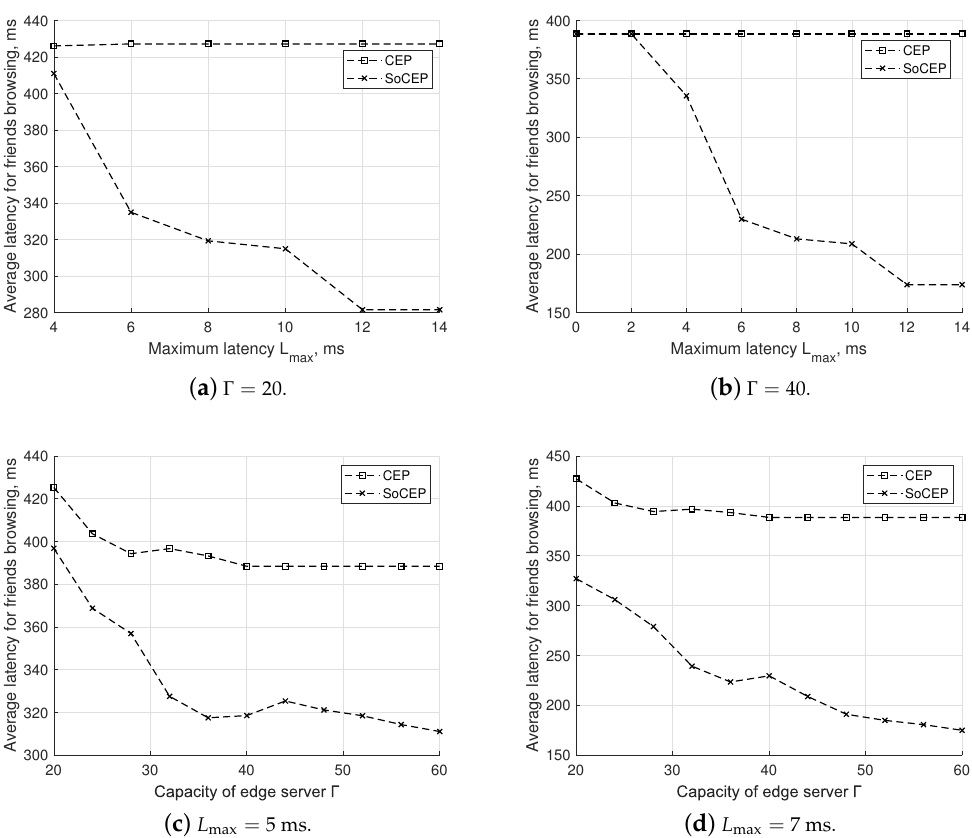
Figure 6. SoCEP vs. CEP: average latency for friends’